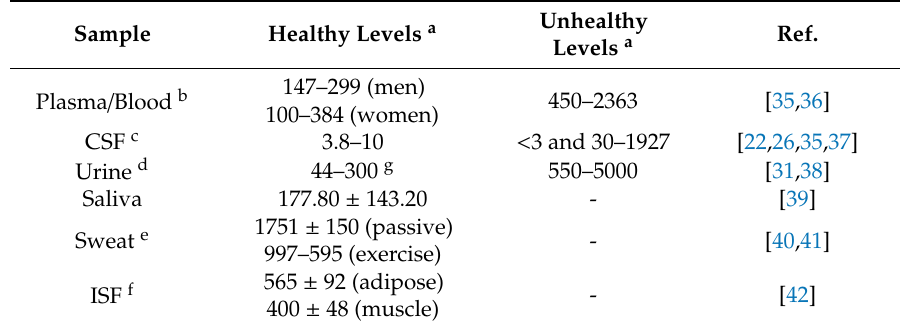
Table 1. Physiological ranges of glycine concentrations ( µ M) in di ff erent body